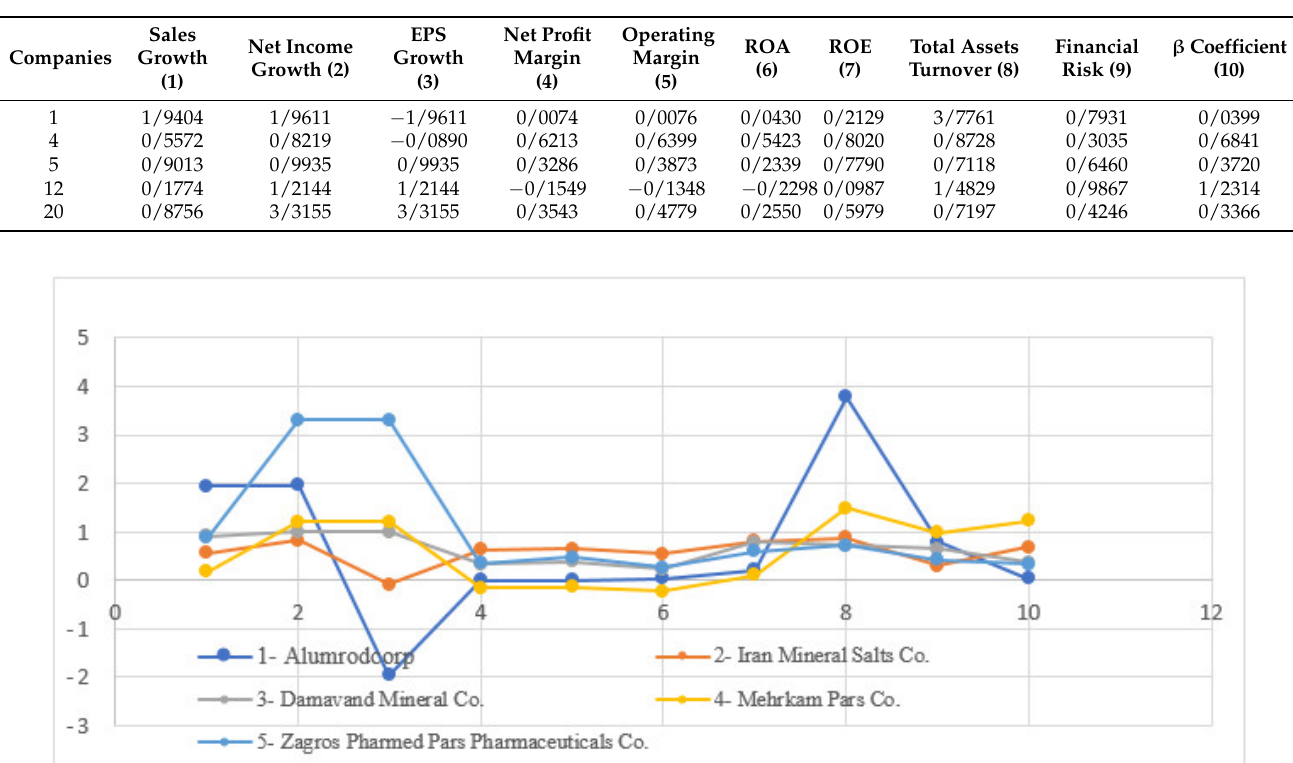
Table 6. Ten criteria for five top-ranked companies.